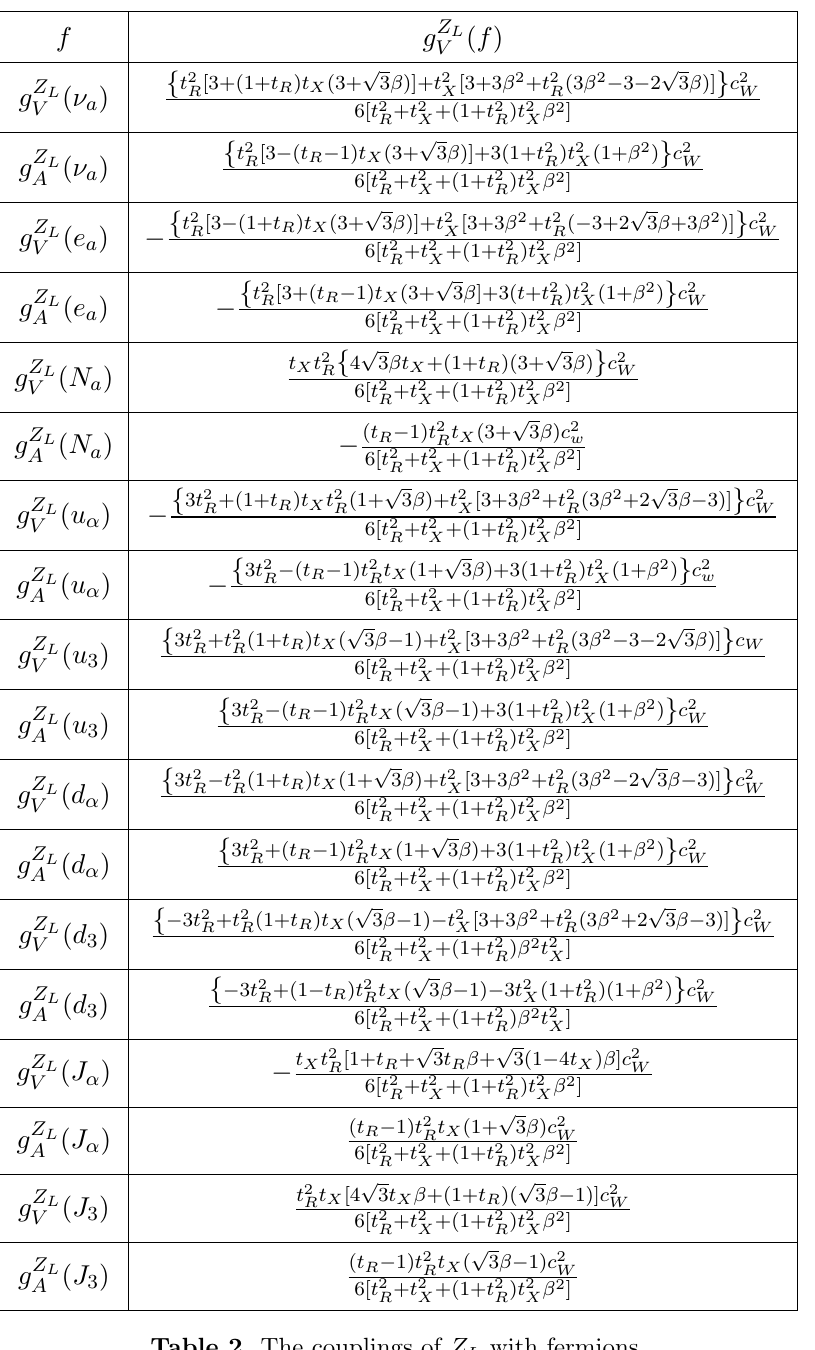
Table 2 . The couplings of Z L with